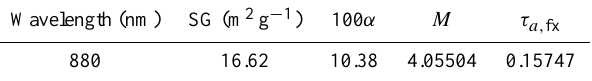
Table 2. Values used in Eq. (10) to calculate the light absorption co- efficients from optical BC measurements with a AE-16 aethalome- ter. α , M and τ a, fx are empirical